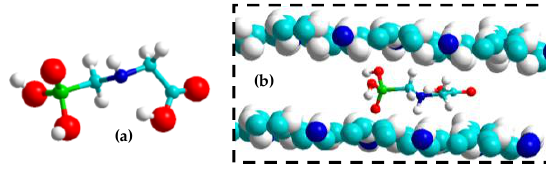
Figure 8. ( a ) Optimized geometries of Gly. ( b ) Most stable configurations of Gly inside the PPy matrix.